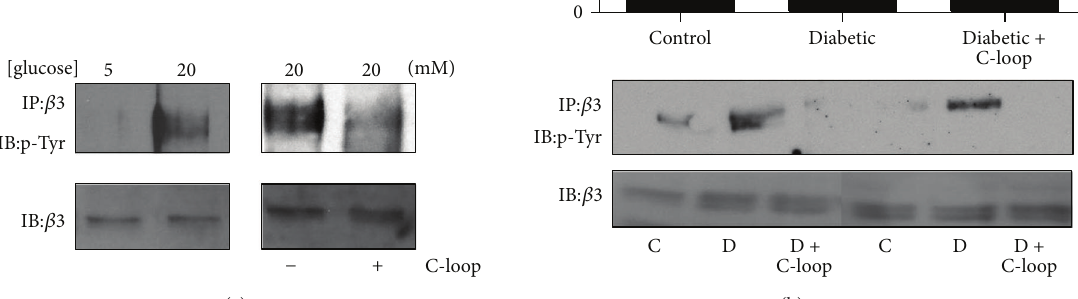
changes that lead to loss of glomerular function.